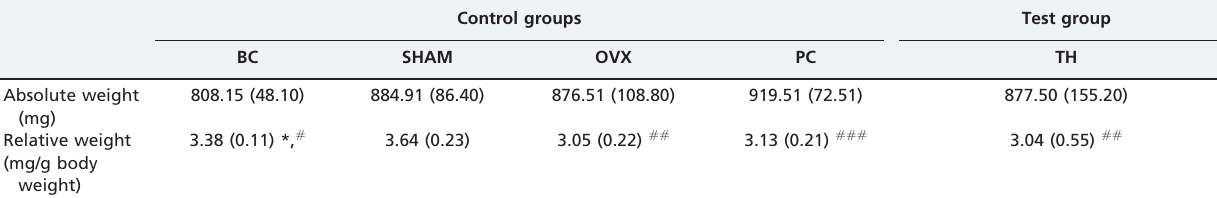
Table 4 - Effects of Tualang honey on weight of femur reported as relative organ weight (mg/g body